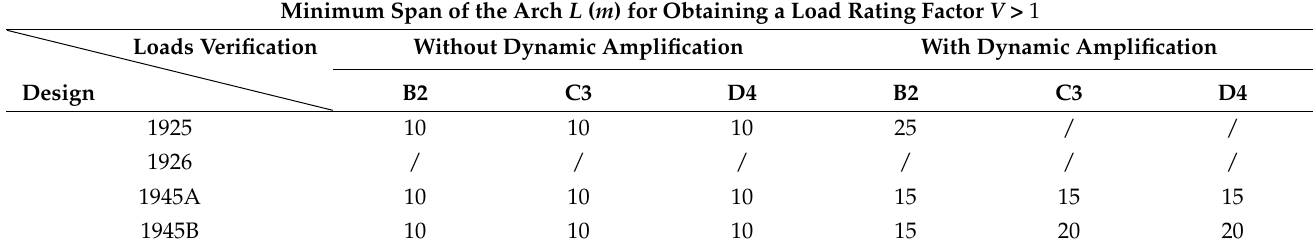
Table 5. Minimum spans of bridges highlighting Load Rating Factor 𝑉 > 1 .